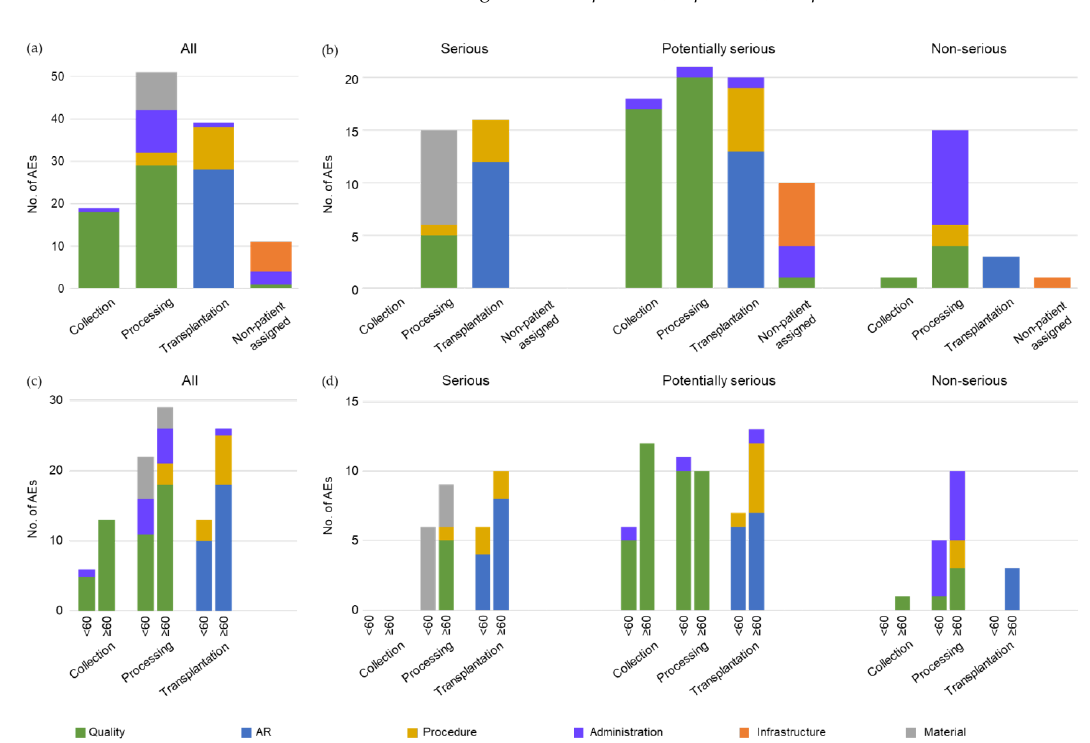
Figure 2. AEs per category (collection, processing, transplantation, non-patient assigned) and subcategory (quality, AR, procedure, administration, infrastructure, material). ( a ) All AEs, ( b ) graded according to seriousness, ( c ) according to age (transplantations in patients <60 years, n = 256 and ≥60 years, n = 254), and ( d ) according to age and seriousness.